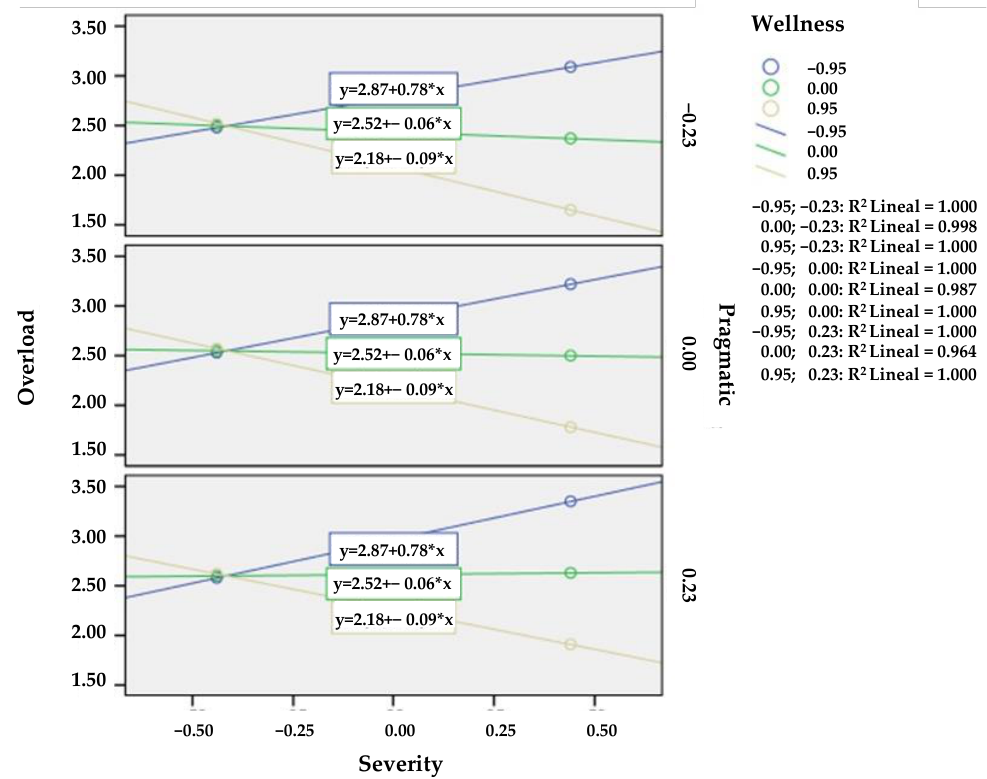
Figure 1. Results of the regression analysis for overload .